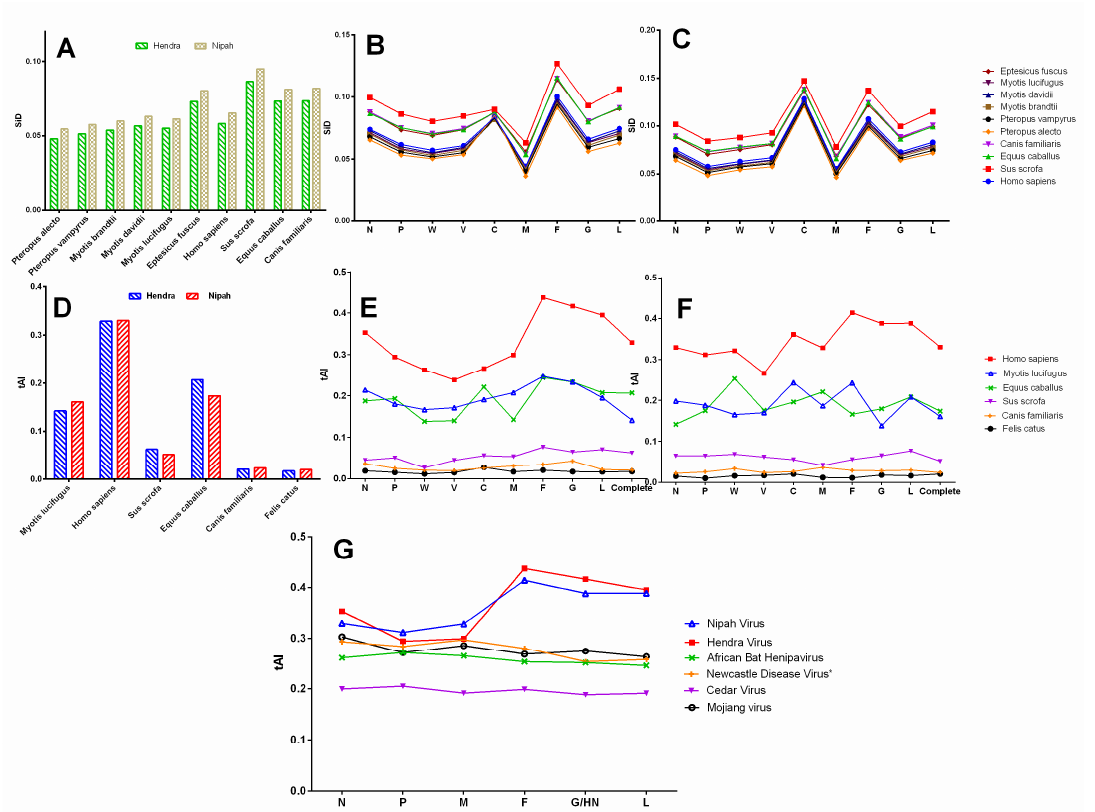
Figure 7. A comparative similarity index (SiD) analysis of complete genomic coding sequences of HeV and NiV ( A ), and individual protein-coding sequences of HeV ( B ) and NiV ( C ) are presented. The tRNA adaptation index (tAI) analysis of complete genomic coding sequences of HeV and NiV ( D ), individual protein-coding sequences of HeV ( E ) and NiV ( F ) are also presented. A comparison of tAI of HeV and NiV with another member of genus Henipavirus , Cedar virus (NCBI Reference Sequence: NC_025351) [2] and henipa-like viruses—African Bat Henipavirus (NCBI Reference Sequence: NC_025256) [42]; Mojiang virus (NCBI Reference Sequence: NC_025352) [43]; and distantly related Newcastle disease virus (NCBI Reference Sequence: NC_002617) is presented in ( G ).